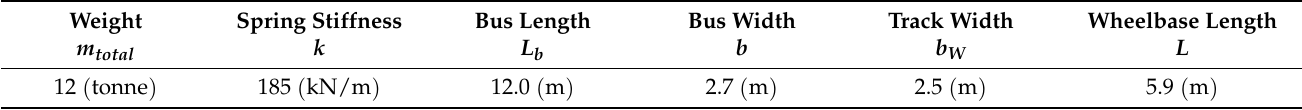
Figure 1. A general perspective of the studied model. Table 1. Characteristics of the studied